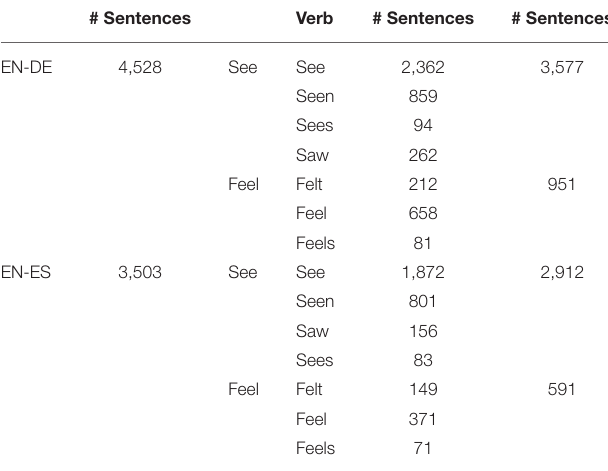
TABLE 1 | Frequency of the sentences used in the final